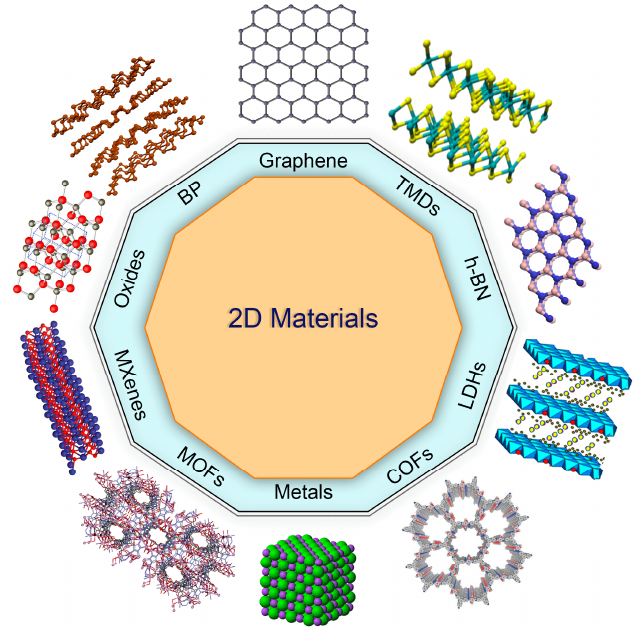
Figure 2. Some of the introduced 2D materials.